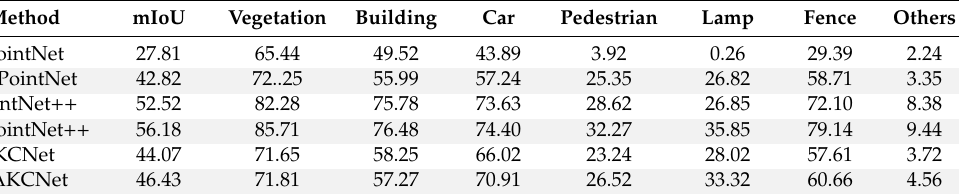
Table 3. Semantic segmentation IoU (%) on the WHU MLS point cloud.